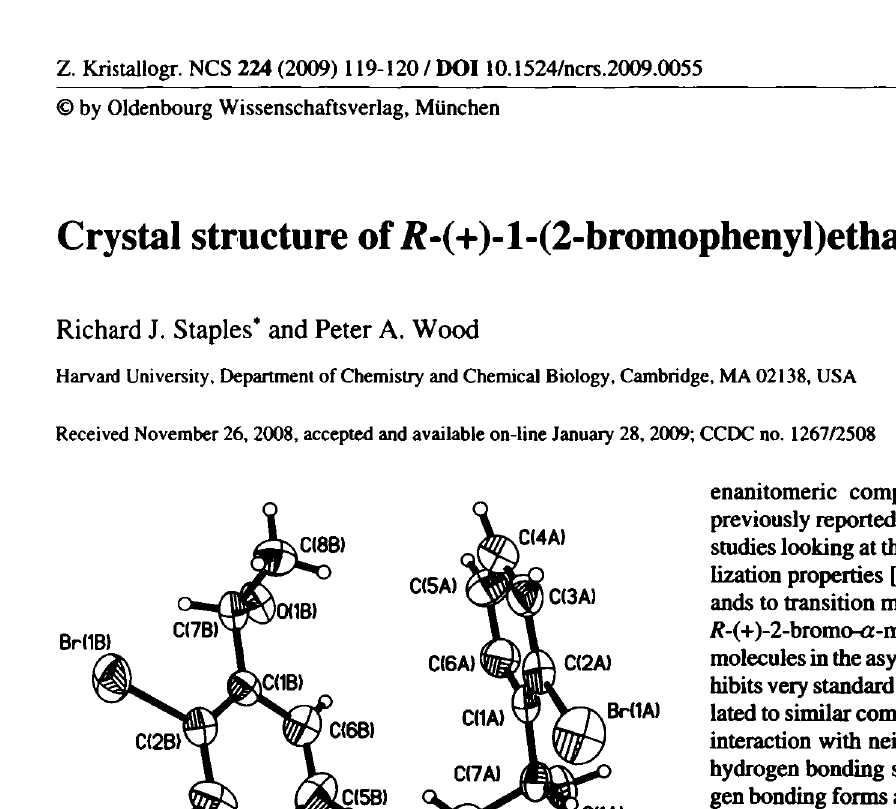
Table 1. Data collection and handling.